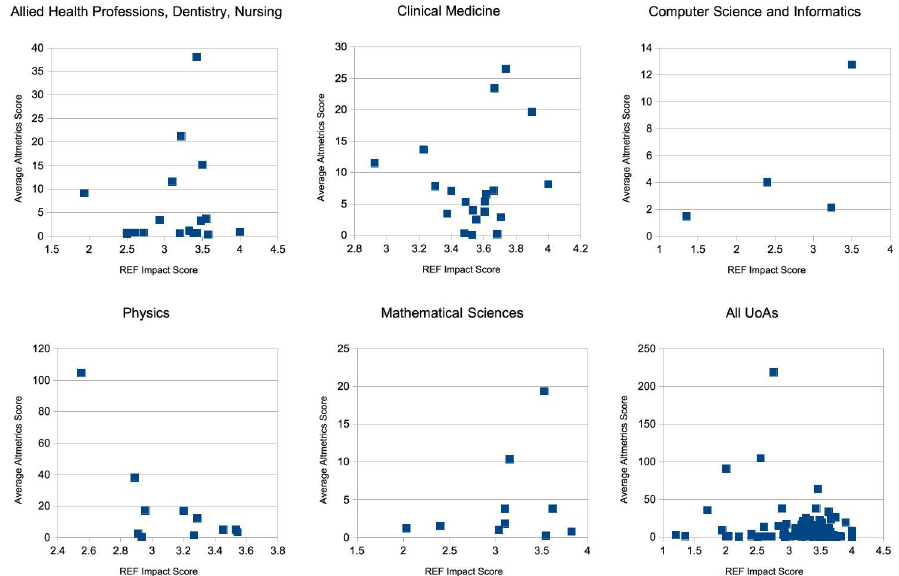
Fig 7. Average Altmetric Score vs AverageREF Impact Score. For All UOAs, one outlier is not displayed at (2.75,218).